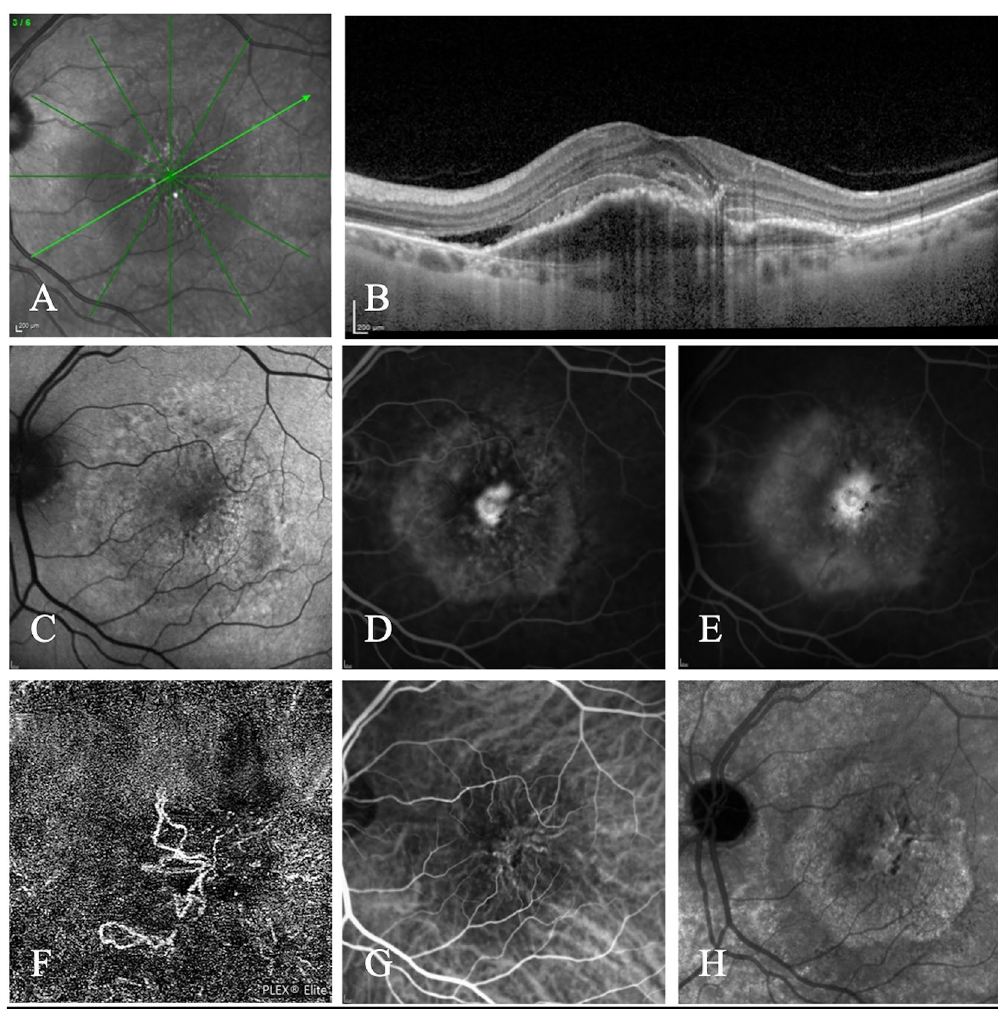
Figure 5. Multimodal imaging of a Caucasian 83-year-old female diagnosed with mixed MNV secondary to neovascular AMD. ( A , B ) The OCT scan reveals a fibrovascular pigment epithelium detachment associated with sub-retinal fluid, sub-retinal hyperreflective material and hyperreflective foci. The sub-foveal choroidal thickness was 216 μm. ( C ) The fundus autofluorescence shows a macular granular hyper/hypoautofluorescence. The fluorescein early ( D ) and late ( E ) angiograms display a homogeneous well-defined intense central hyperfluorescence (type 2 MNV) and a pinpoint surrounding hyperfluorescence (type 1 MNV) with late leakage of both components. ( F ) OCTA shows the presence of flow within the neovascular lesion with irregular filamentous pattern. ( G ) The early indocyanine green angiogram clearly reveals a central net of small vessels (type 2 MNV). ( H ) The late phase angiogram demonstrates a hyperfluorescent plaque (type 1 MNV). I = 0 (mixed MNV); C = 0 (< 300 μm); A = 0 (> 65 years); S = 0 (female); E = 0 (No early pachyvessels); O = 3 (evidence of MNV at OCTA); f = + 0.5 (presence of SRF). The patient scores